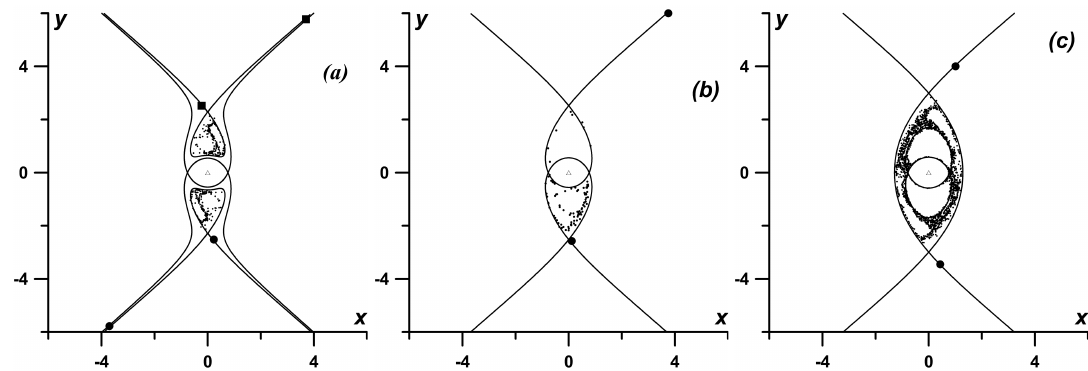
Figure 10. Examples of Poincaré maps for a purely strained deformation flow ( Ω 0 = 0) for different steady-state separatrix configurations: ( a ) S 0 = 0.2, ν = 0.03, and ε = 0.05; ( b ) S 0 = 0.17759, ν = 0.02756, and ε = 0.05; and ( c ) S 0 = 0.14, ν = 0.03, and ε = 0.033. The corresponding steady-state separatrices are plotted by solid lines. The positions of the bottom vortices as they enter and leave the region of interest are marked by squares and